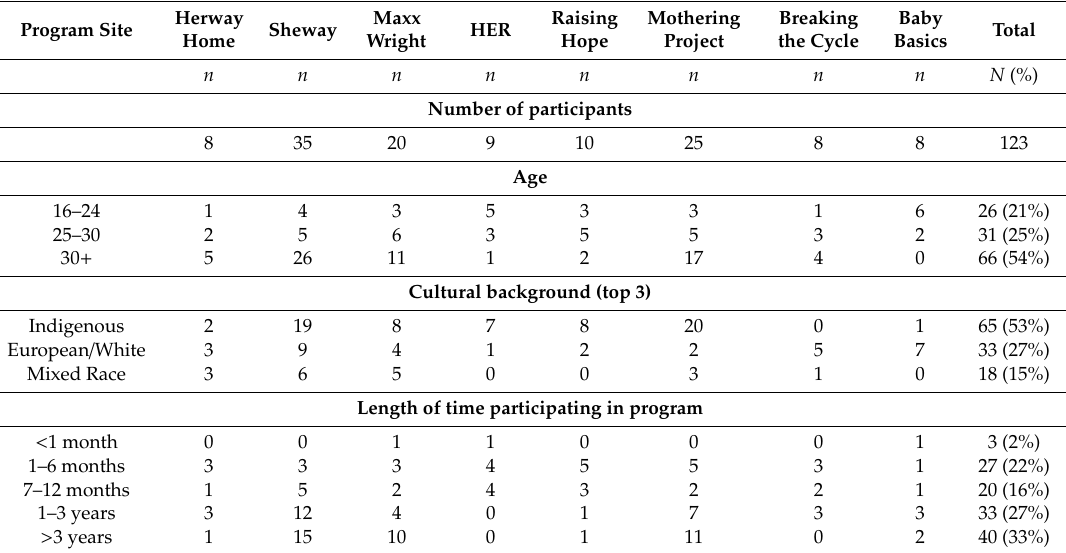
Table 1. Characteristics of client questionnaire